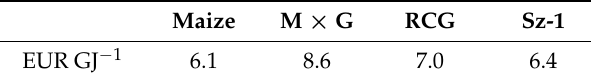
Table 19. Price of to 1 GJ of generated energy.